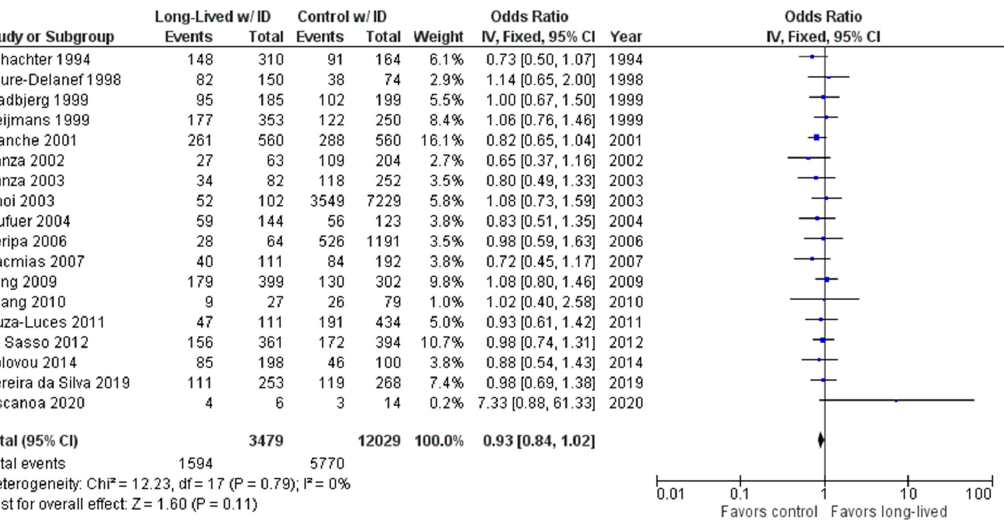
Figure 5. Comparison of DD genotype frequency in long-lived and control groups. The ages of long- lived and control groups are described in Table 1. The p- value is indicated by P in the Figure.